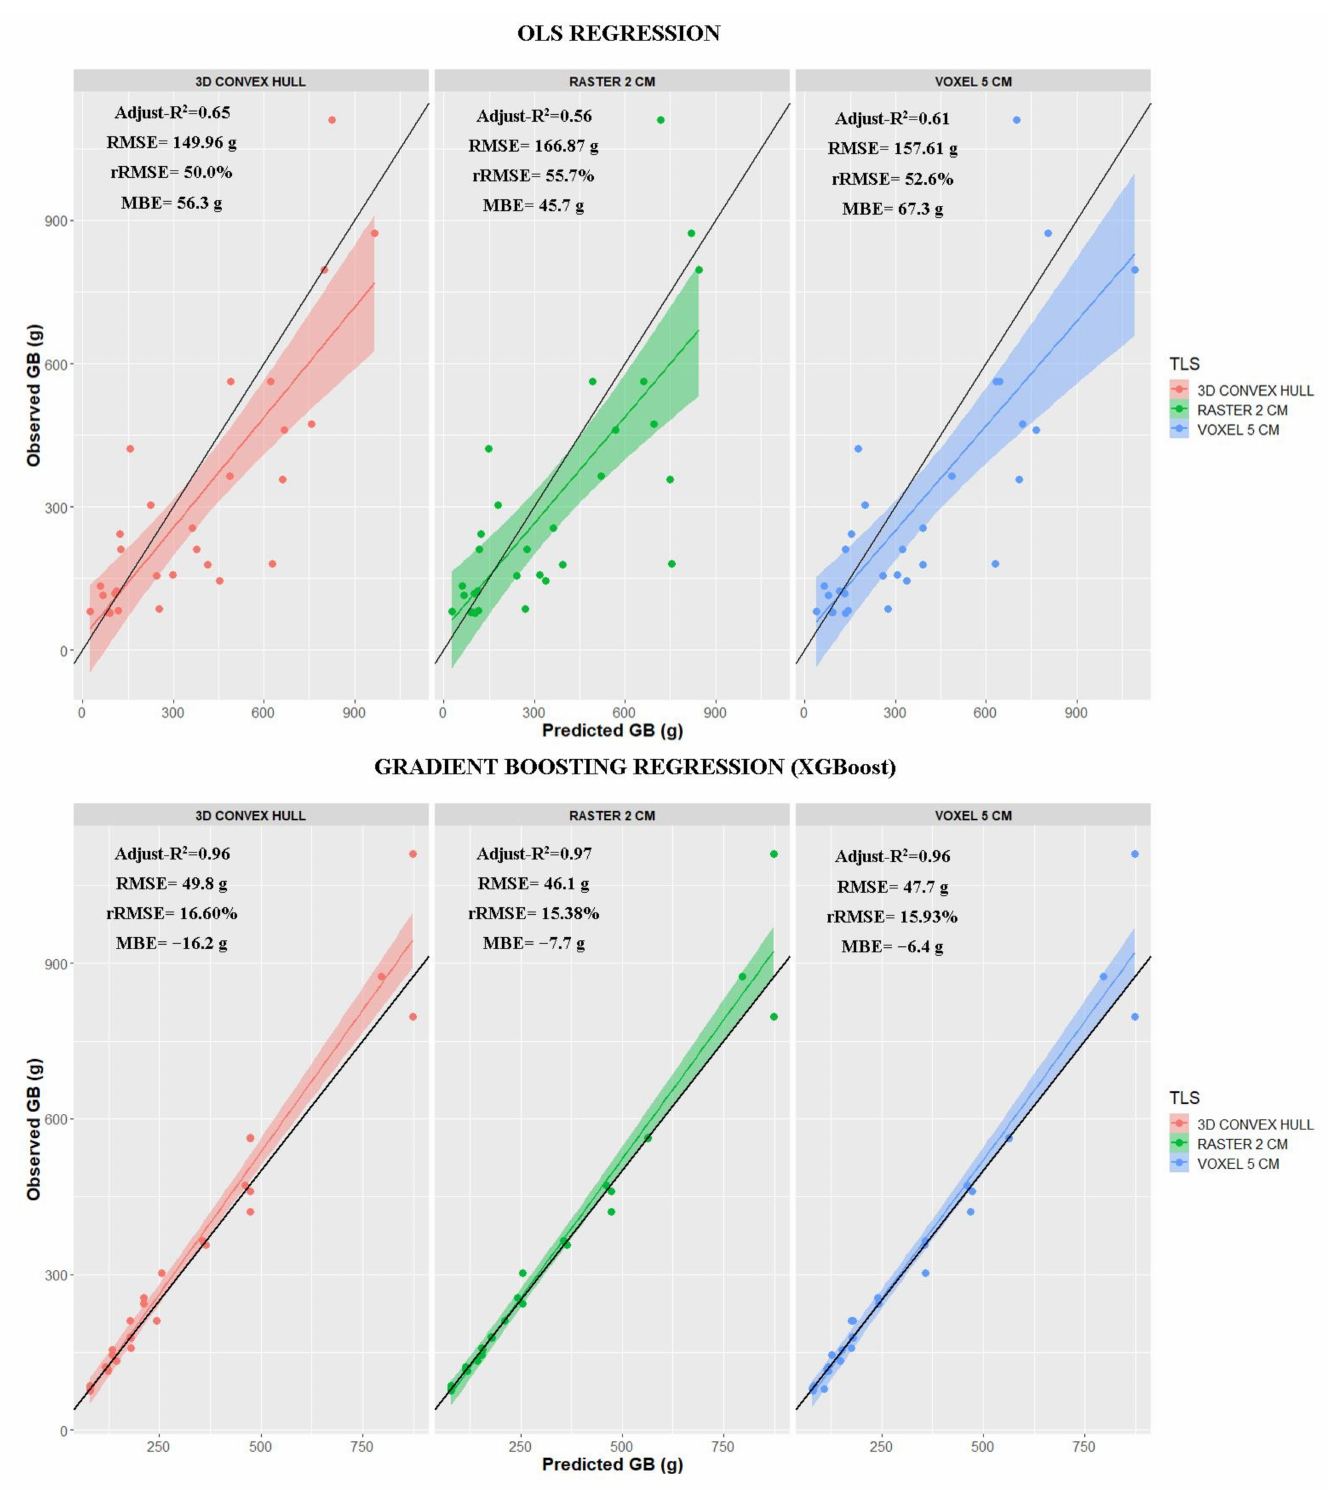
Figure 4. Relationships between observed and estimated GB (g) using equations in Table 5 for OLS regression analysis ( up ) and XGBoost analysis using plant volume derived for TLS and NDVI as GB predictors ( down ). Black line represents 1:1